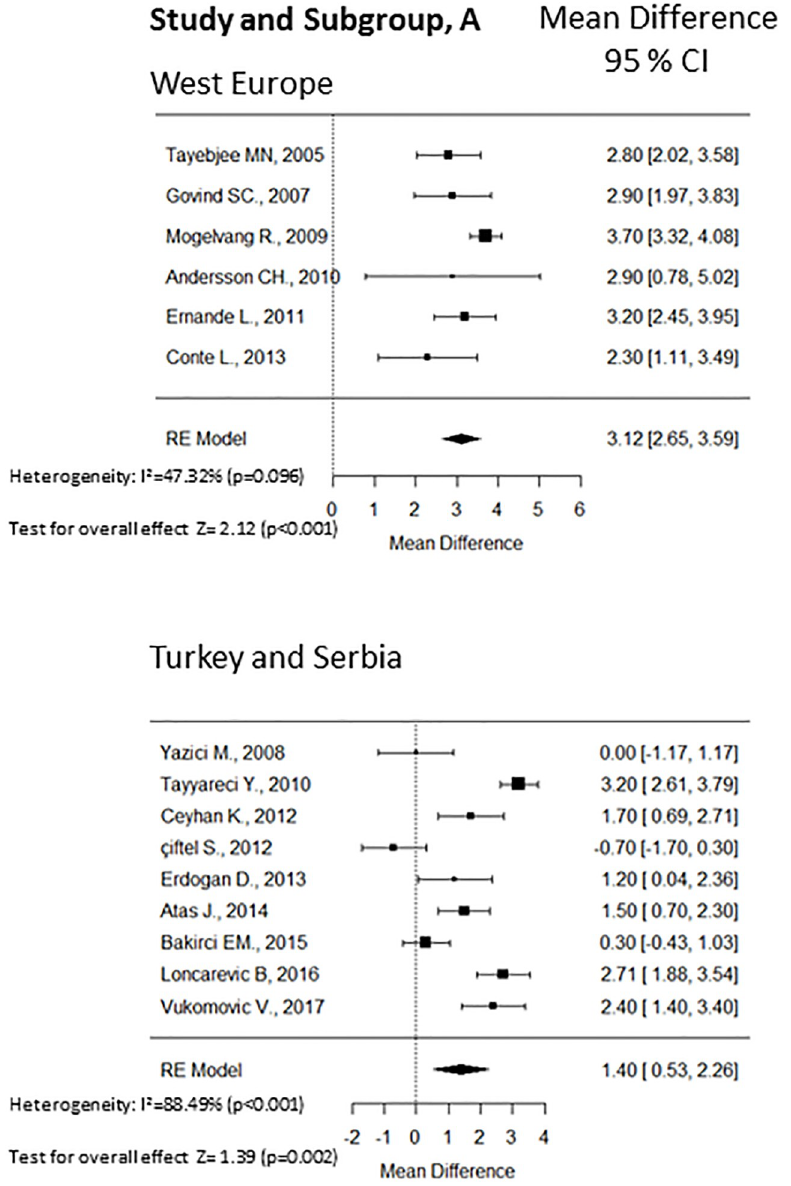
Fig 3. The Forest plot of the WMD with 95% C.I. of the subgroup analyses: Panel A, region; panel B, matching; panel C, hypertension; panel D, glycemic control. A positive value signifies that E/e’ is higher in patients with